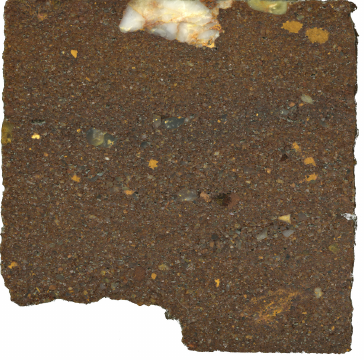
Figure 1. Petřín sandstone sample captured using high-resolution flatbed scanner.